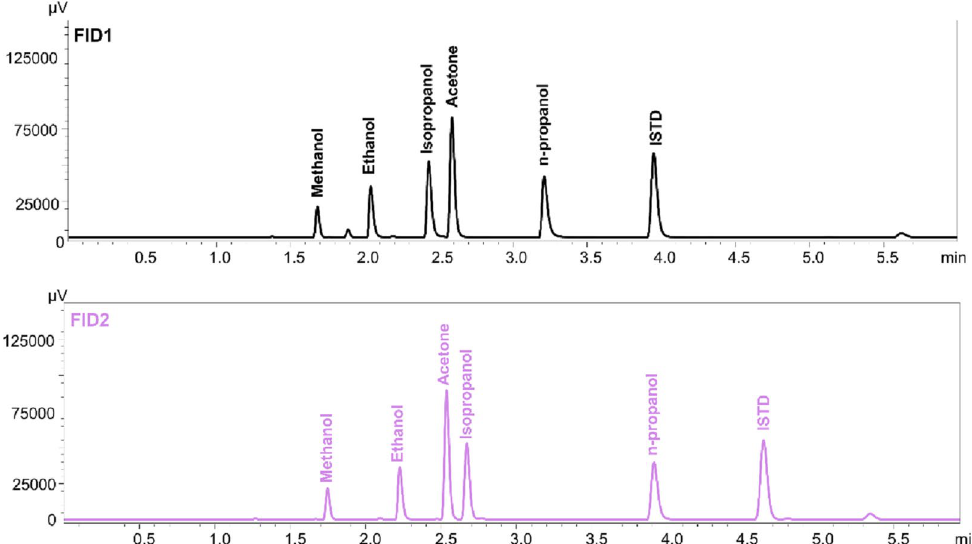
Figure 3. Chromatograms of other volatile compounds routinely determined in forensic toxicology (methanol, ethanol, acetone, isopropanol, n -propanol) with ISTD (propionitrile). Black line is illustrating result from FID1 and violet line from